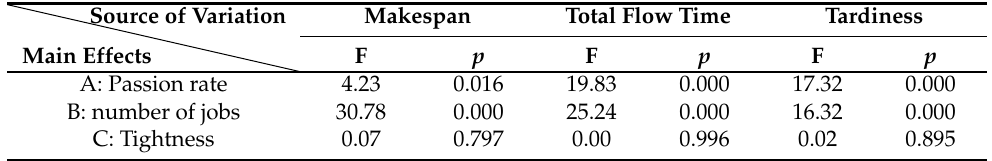
Table 7. ANOVA of different objective functions.